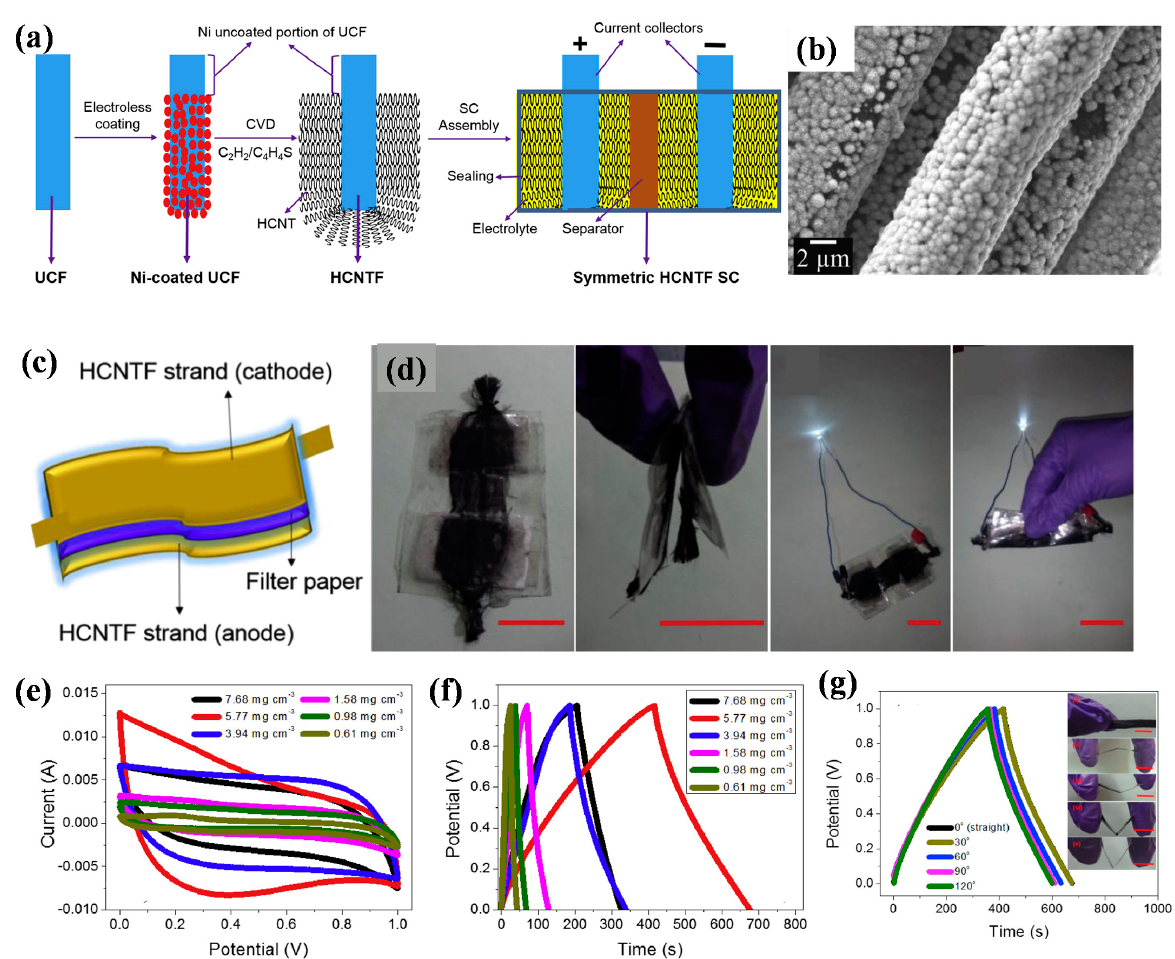
Figure 3. ( a ) Schematic of the overall fabrication process of flexible HCNTF SC, ( b ) SEM image of nickel coated unidirectional carbon fiber (UCF), ( c ) schematic of the all-solid-state HCNTF SC, ( d ) fully solid-state flexible HCNTF SC module consisting of two all-solid-state flexible HCNTF SCs connected in series, module bend 180 ⁰ , module discharges via a white LED bulb and module bend at 180° while discharging via a white LED bulb, ( e ) CV at constant scan rate with different densities of HCNTF, ( f ) galvanostatic charge–discharge curves at a constant current density of 0.28 mA cm 2 of HCNTF SC utilizing electrode with different HCNT densities, ( g ) galvanostatic charge–discharge curves [inset: digital images of the HCNTF SC bend at 0° (i), 30° (ii), 60° (iii), 90° (iv) and 120° (v), scale bar = 1 cm] of the HCNTF SC utilizing electrode with HCNT density of 5.77 mg cm − 2 bent at different angles. Reproduced from Ref. [112]. Copyrights (Elsevier, 2016).